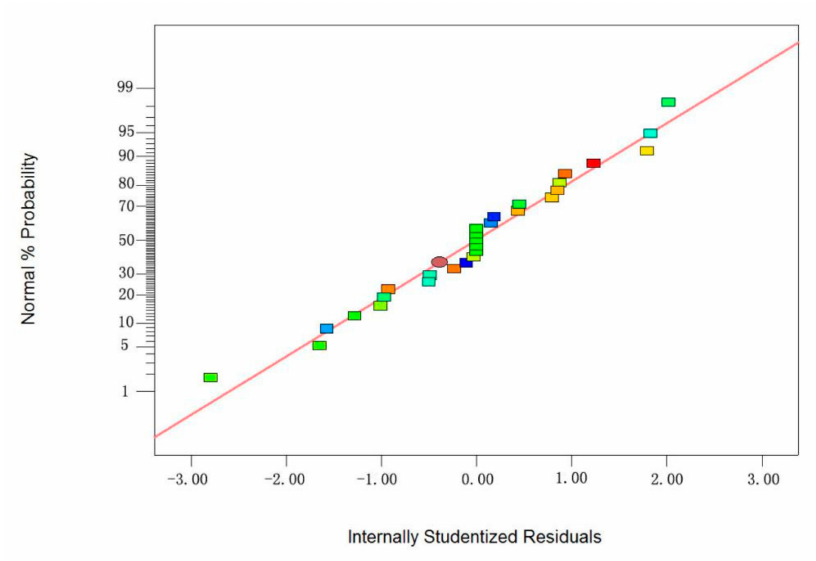
Figure 8. Normal plot of studentized residuals vs. normal %